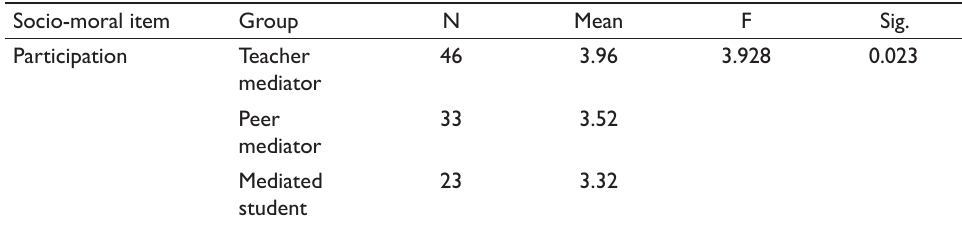
Table 6: Significant differences in the socio-moral items between peer mediator, teacher mediator, and mediated student